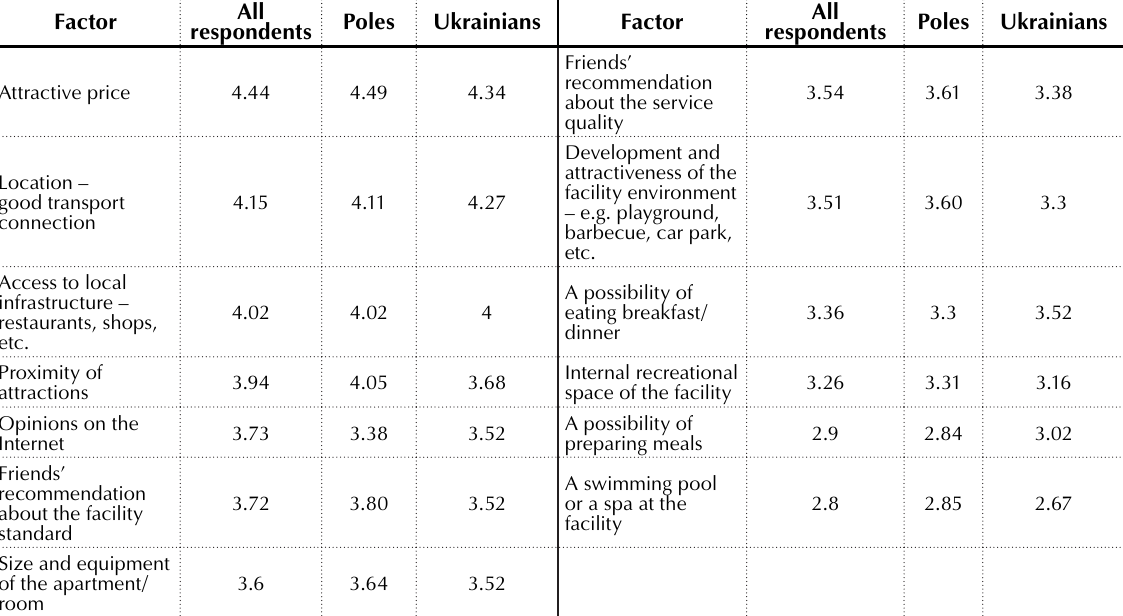
Source: Own work based on the survey